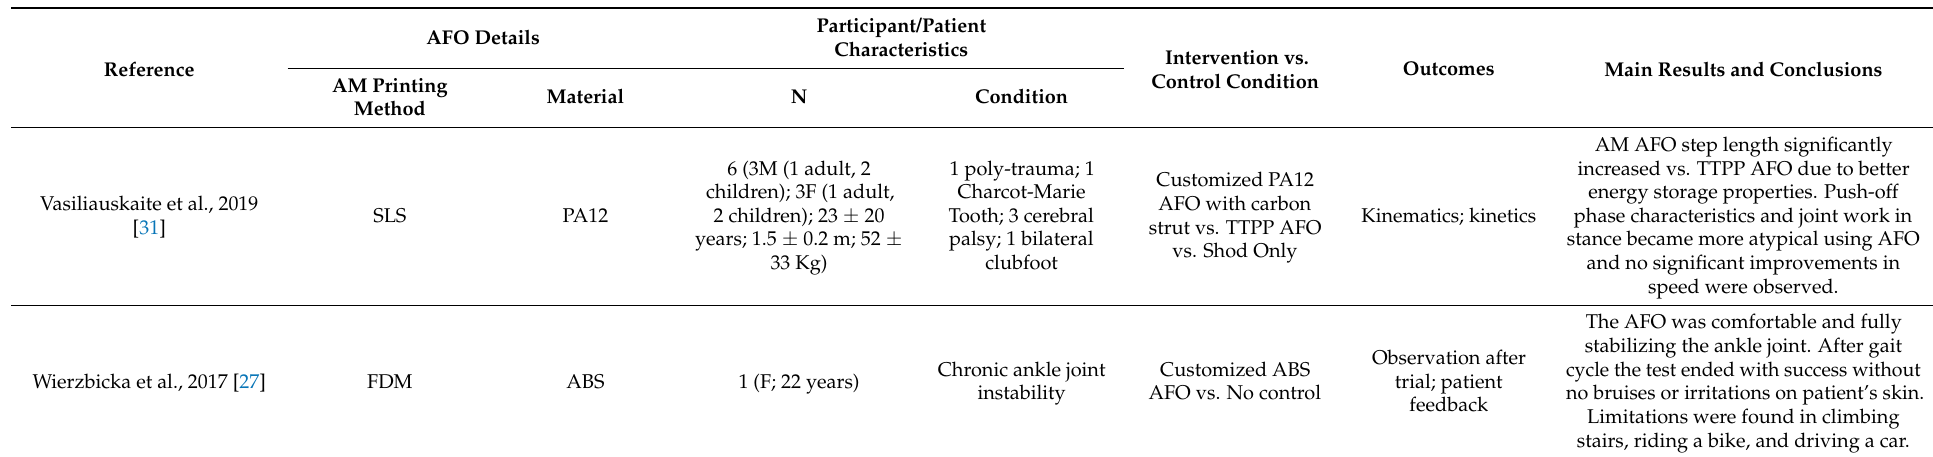
cycle the test ended with success without no bruises or irritations on patient’s